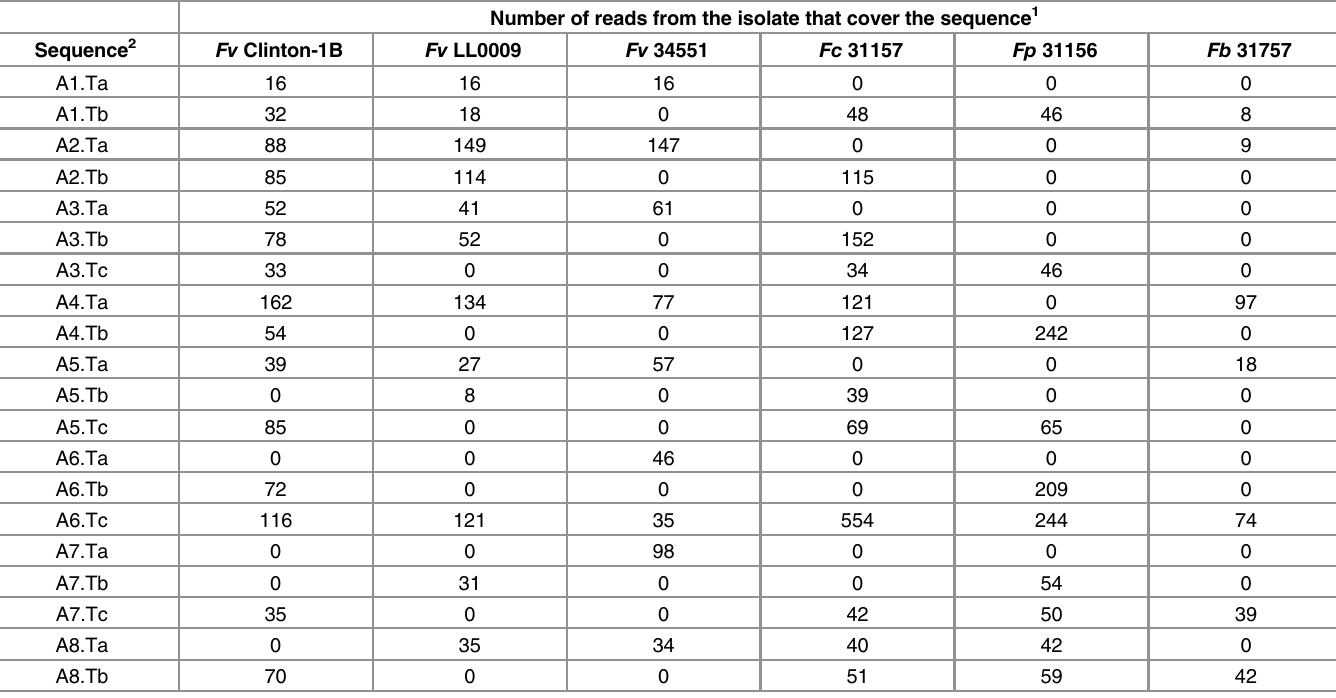
Table 3. The number of reads from the isolate that link all alleles in the sequence. Number of reads from the isolate that cover the sequence